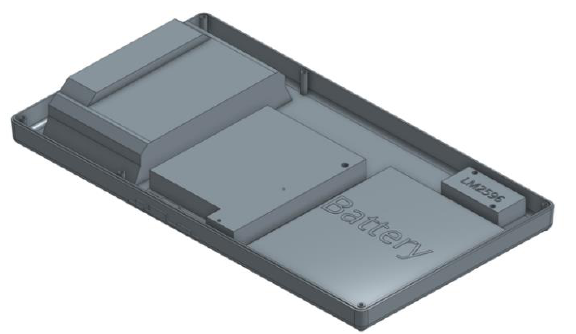
Figure 4. The three-dimensional (3D) rendered enclosure for housing the solar controller, single-board computer, and DC boost converter.